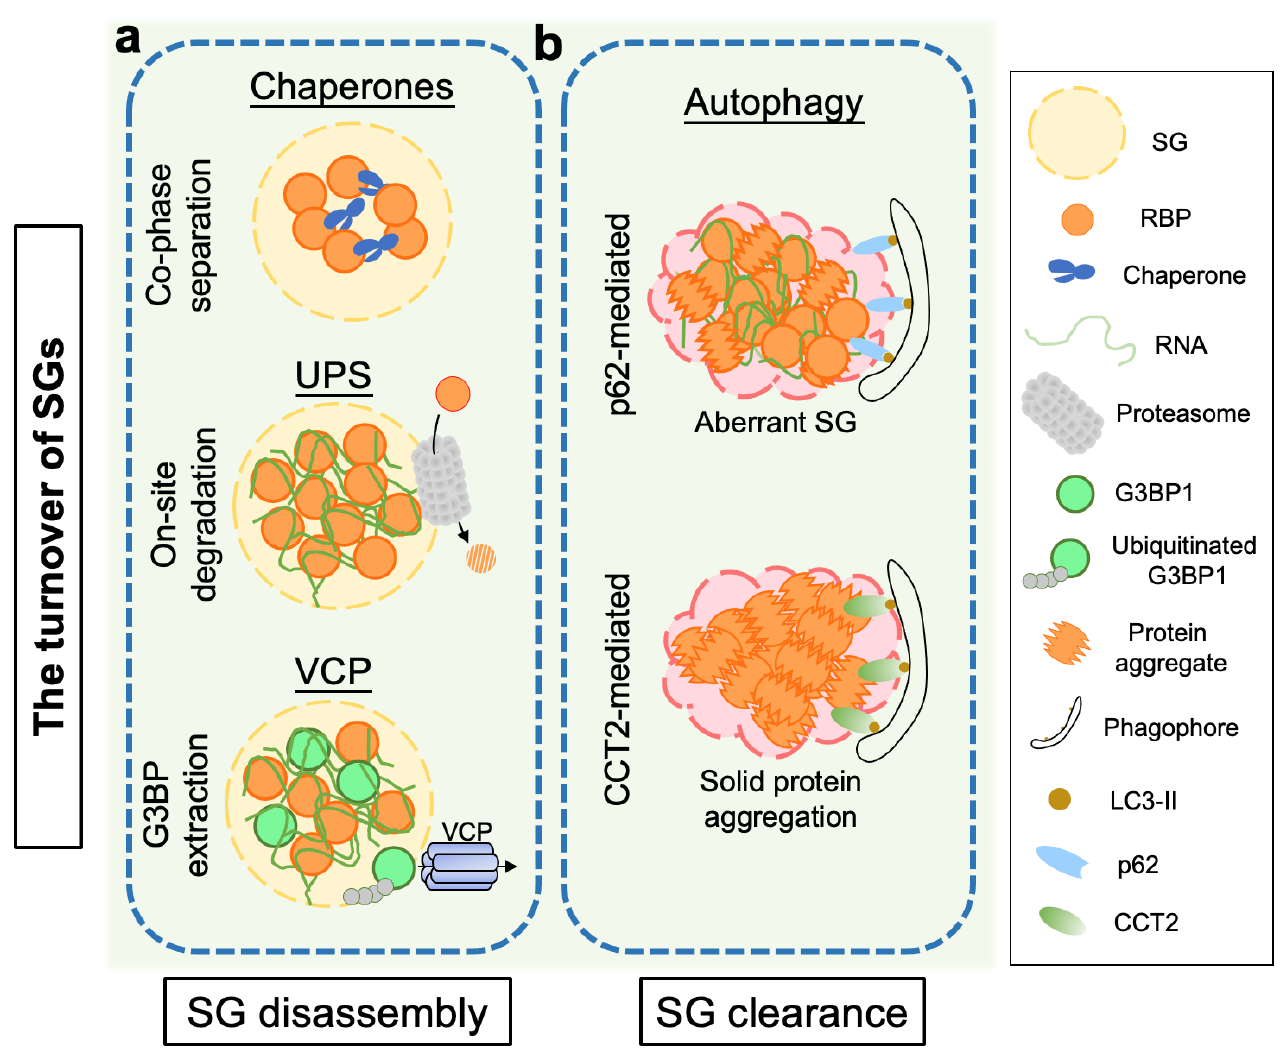
Figure 3. The turnover of SGs—disassembly and clearance. ( a ) The disassembly of liquid-like, dynamic SGs are mediated by molecular chaperones, the UPS and VCP. Chaperones prevent liquid-to-solid phase transition of SGs by co-phase separation with SG-associated RBPs; the proteasome provides an on-site degradation machinery for elimination of misfolded proteins in SGs; and VCP dissociates ubiquitinated G3BP1 from SGs, trigging SG disassembly. ( b ) Aberrant, persisting SGs and solid protein aggregates are recognized by the autophagy receptors p62 and CCT2, respectively, which are subsequently eliminated by autophagic degradation. Abbreviations: CCT2, chaperonin-containing TCP-1 subunit 2; G3BP1, Ras GTPase-activating protein-binding protein 1; RBP, RNA-binding protein; SGs, stress granules; UPS, ubiquitin-proteasome system; VCP, valosin-containing protein.